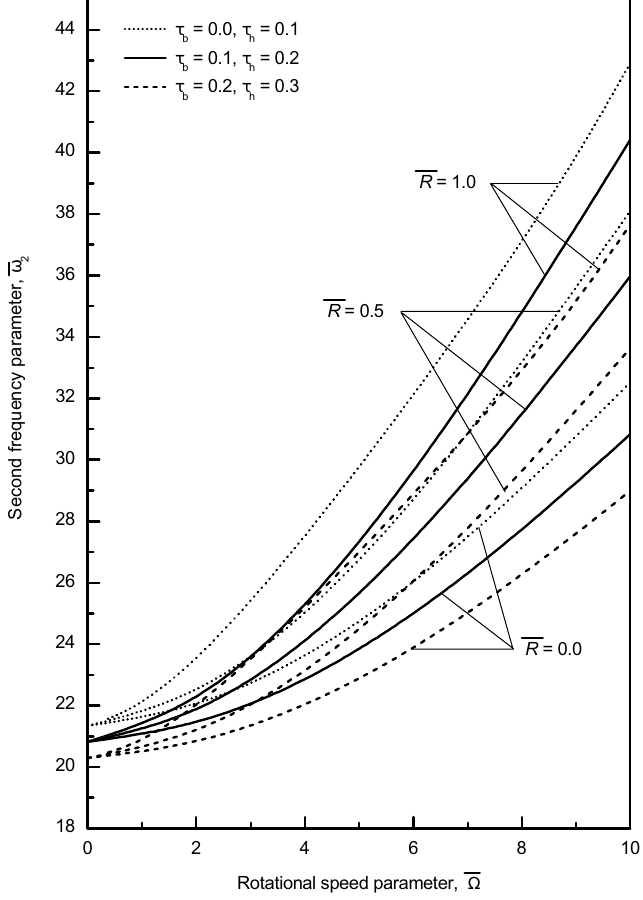
Fig. 4. Effect of unequal tapering on the second frequency parameter of rotating Euler-Bernoulli beam. (cid:1) 1 − 104 τ k e = − 140 4 , 2